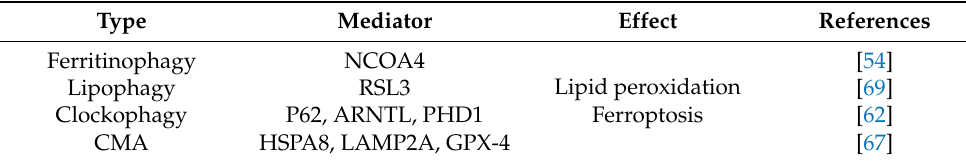
Table 2. Pathways of ferroptosis regulation by